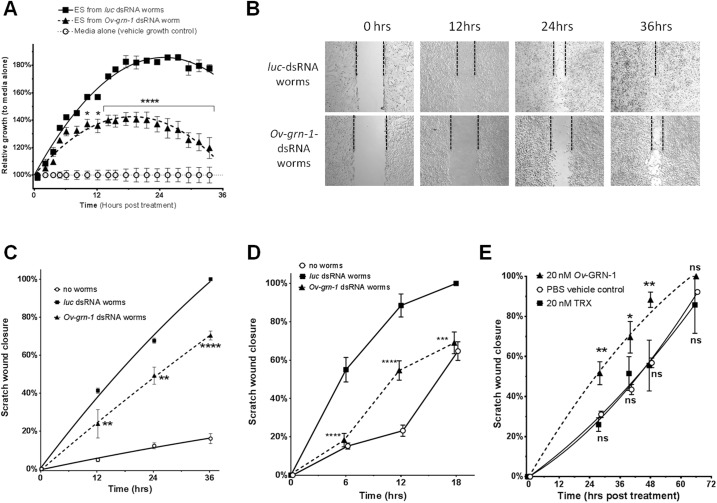

Ov-GRN-1 stimulated wound repair in vitro.
(A) Cholangiocytes exposed to ES products from flukes where Ov-grn-1 had been silenced by RNA interference displayed significantly reduced proliferation over 36 h of co-culture. ES products (10 μg/ml) were derived from flukes that were exposed to dsRNAs for 5 days. Cell proliferation was monitored in real time using xCELLigence; every tenth data point is shown to aid visualization. Statistical comparisons were between Ov-grn-1- and luc-dsRNA-treated parasites. (B) Images of the scratch assay involving H69 cholangiocyte monolayers co-cultured in Transwell plates with Ov-grn-1 or luc-dsRNA-treated. Dotted lines denote wound edges over time. (C) Selected time points were measured from the photographs in (B); statistical comparisons were between cells cultured with Ov-grn-1-and luc-dsRNAs. (D) Wound healing scratch assay as shown in panel c but using the CCA cell line M214 (D). (E) Wound healing scratch assay as shown in panels (C) and (D) but recombinant protein applied to cells instead of co-culturing cells with live flukes. Statistical comparisons were between 20 nM rTRX and rOv-GRN-1 treatments or rTRX and PBS treatments. For all panels, data points represent the averages of two or three biological replicates with 3–5 biological replicates displayed with SEM error bars (some bars masked by data points). *P<0.05, **P<0.01, ***P<0.001, ****P<0.0001, ns = not significant. Additional data shown in S2 Fig.